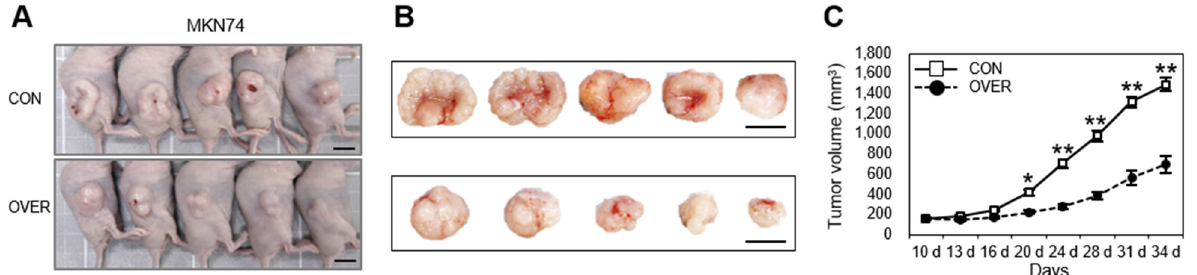
Figure 5. Xenograft assay with SSTR2 -OVER MKN74 cells. ( A ) Mice were sacrificed at 34 d after injection of SSTR2 -OVER MKN74 cells and control vector-transfected MKN74 cells into nude mice and tumor volumes were measured. Scale bar, 1 cm. ( B ) Photographs of tumors excised at 34 d after injection. ( C ) Tumor growth curves for SSTR2 -OVER MKN74 cells and control MKN74 cells in nude mice. * p < 0.05, ** p < 0.01 versus control (CON) cells.